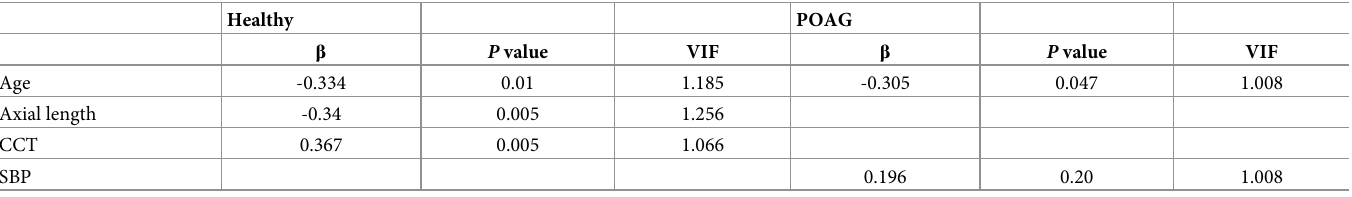
Table 8. Multivariate regression analysis of macular choroidal interstitial area with associated factors.